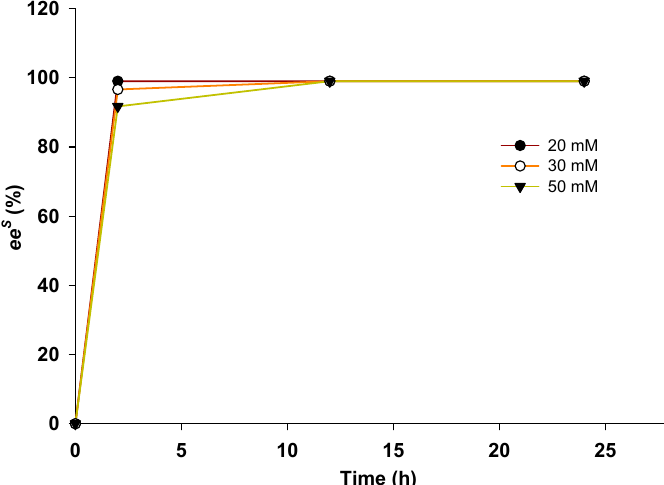
Figure 7. Reaction profiles for the kinetic resolution of 20, 30 and 50 mM rac- a7 using Chi-AmDH-AlaDH whole cell system; Reaction conditions: (20 / 30 or 50 mM rac- a7 , 40 / 60 or 100 mM pyruvate), 100 mM glycine bu ff er pH 10.0, 30 mg DCW / mL Chi-AmDH-AlaDH cells, 37 ◦ C, 200 rpm for 24 h).